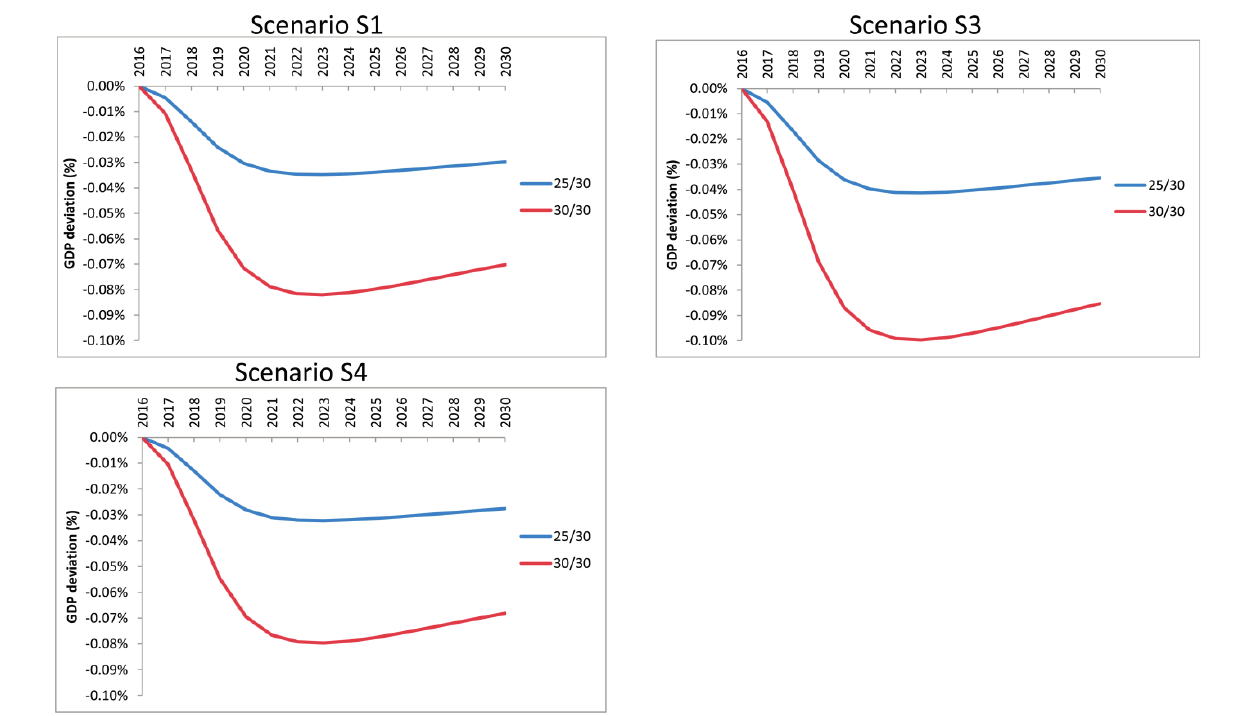
Figure 12. Effect of NCRE law modifications on the level of GDP (% over baseline deviations).